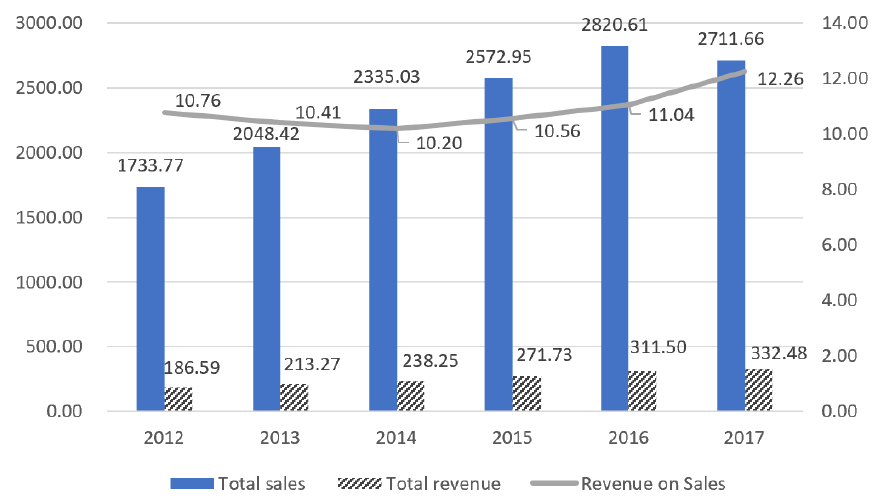
Figure 1. Sales and revenue of the pharmaceutical industry in China (billion yuan). Data resource: China National Bureau of Statistics, http://www.stats.gov.cn.